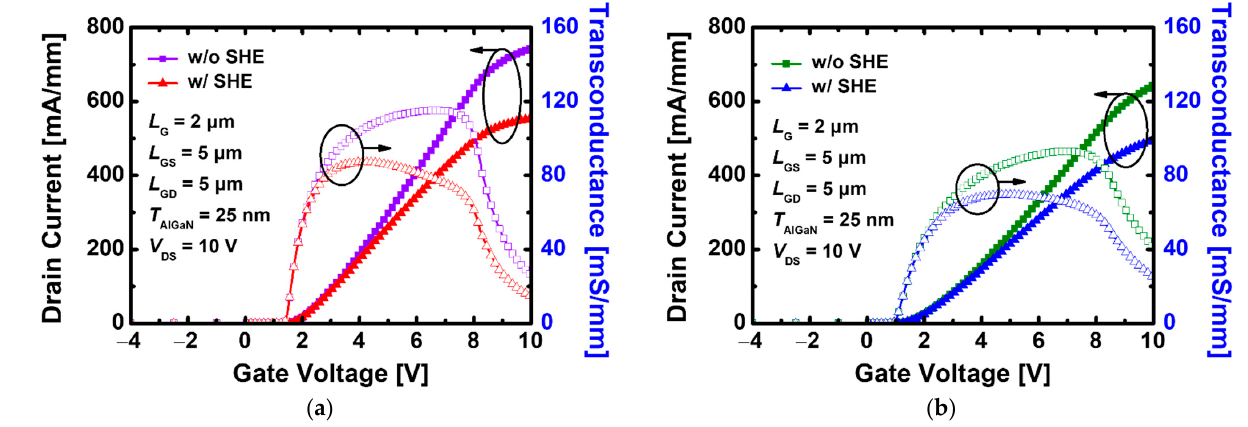
Figure 2. I D - V G transfer characteristics with and without SHE in recessed-gate GaN MOSFET using ( a ) the stacked TiO 2 /Si 3 N 4 dual-layer insulator, ( b ) Si 3 N 4 single-layer insulator at V DS = 10 V.